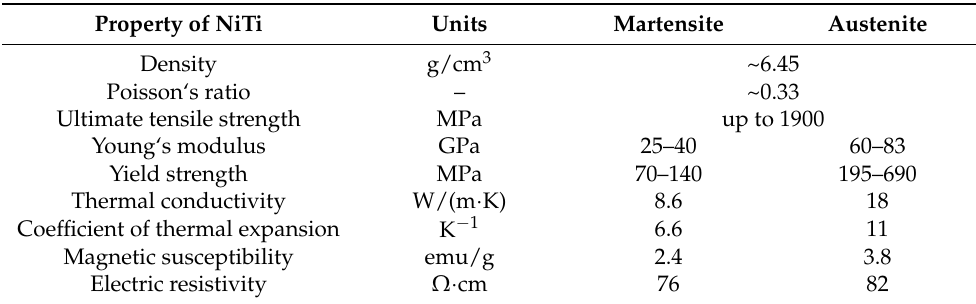
Table 1. The fundamental mechanical and physical properties of NiTi shape memory alloys (SMA)